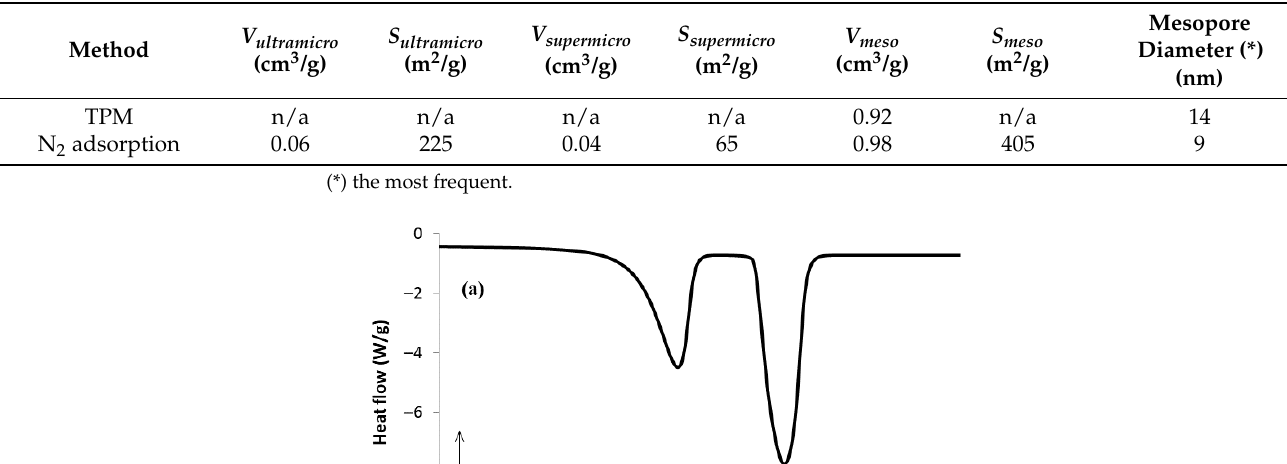
Table 2. Porous characteristics of MC sample determined by TPM and N 2 adsorption at − 196 ◦ C.